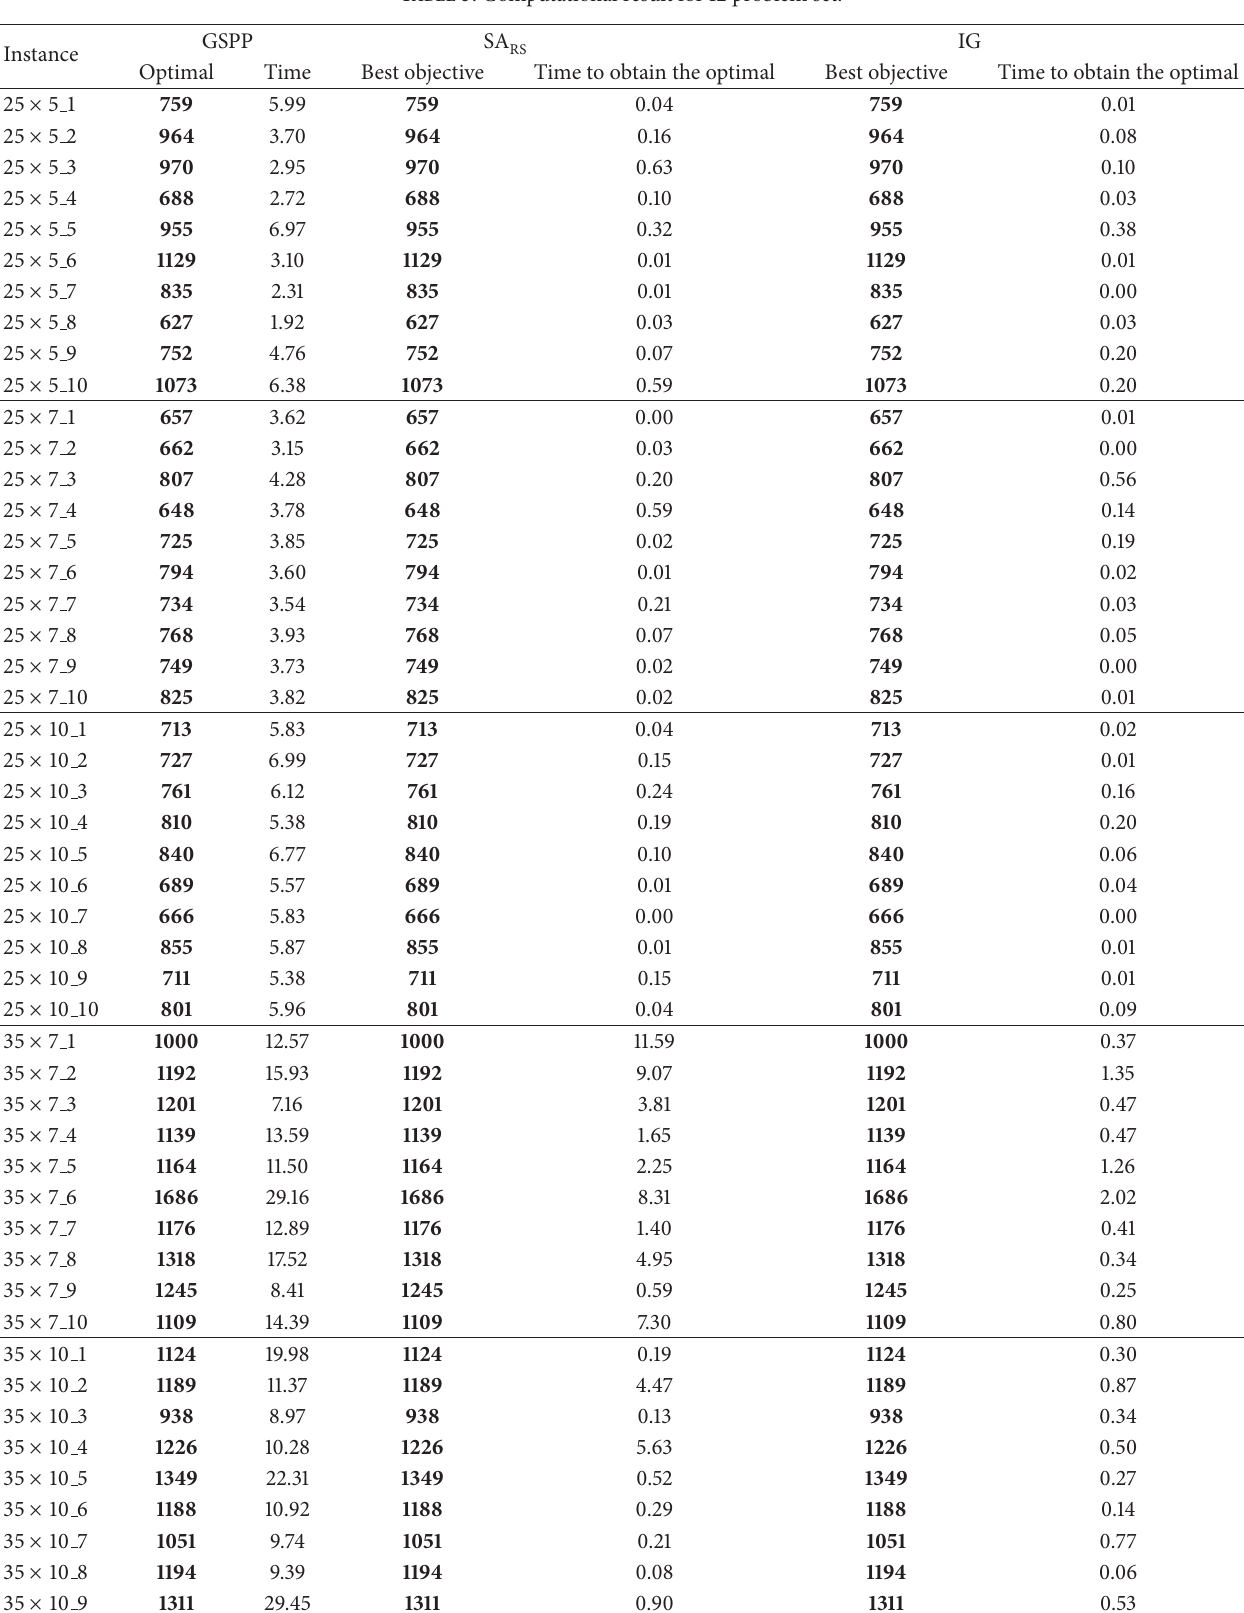
Table 3: Computational result for I2 problem